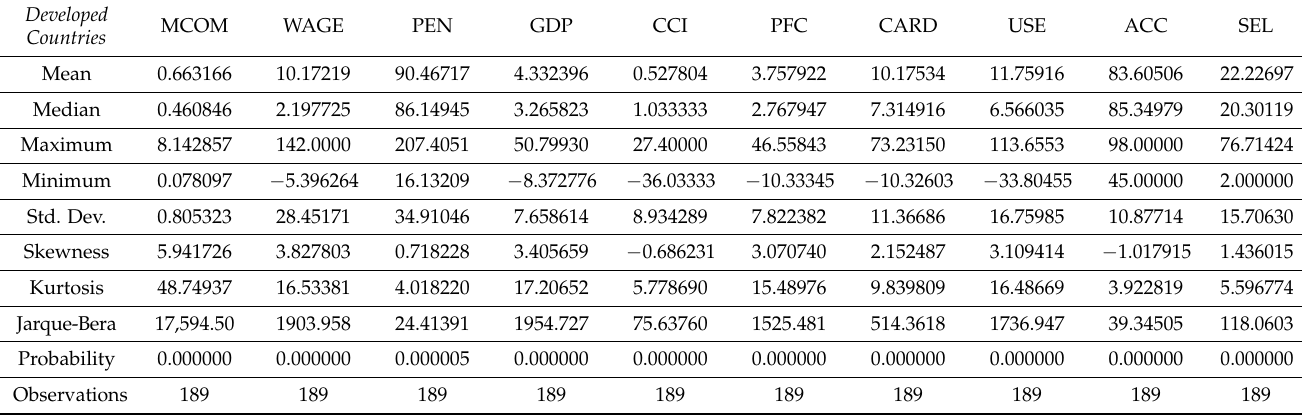
Table A3. Descriptive analyses of developed